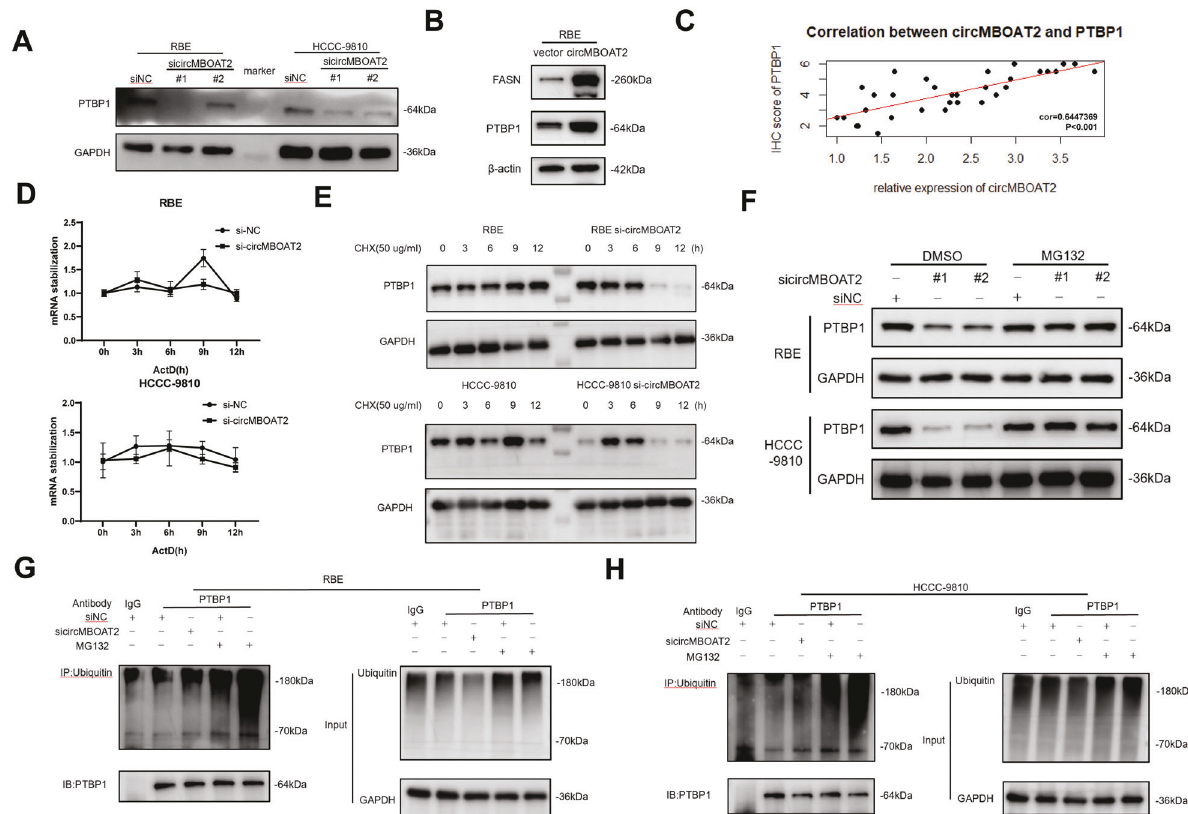
Fig. 5 CircMBOAT2 protects PTBP1 from ubiquitin/proteasome-dependent degradation. A , B Protein levels of PTBP1 in RBE and HCCC-9810 cells with circMBOAT2 knockdown and overexpression. GAPDH or β -actin was used as a negative control. C Correlation between the expression of circMBOAT2 and PTBP1 protein by Pearson correlation analysis. D Analysis for RNA abundance of PTBP1 treated with Actinomycin D (2 μ g/ml) at the indicated time point by qRT-PCR. E Analysis for protein abundance of PTBP1 treated with cycloheximide (CHX) (50 μ g/ml) at the indicated time point by western blot. F CircMBOAT2 knockdown and control RBE and HCCC-9810 cells were incubated with MG132 (10 μ M) for 8 h. Protein levels of PTBP1 were measured by western blot. G , H Immunoprecipitation detected ubiquitination modi fi cation of PTBP1 with or without MG132 treatment in RBE and HCCC-9810 cells. IgG was used as a negative control. Ub